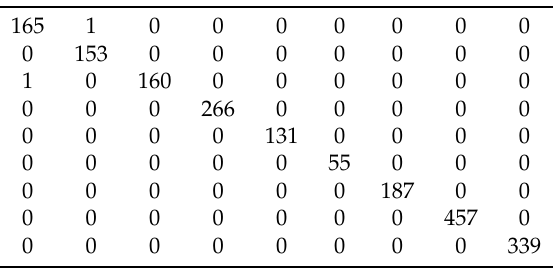
Table 3. Confusion matrix corresponding to C2R-CNN test evaluation with 100 epochs when 9 pose classes are considered.